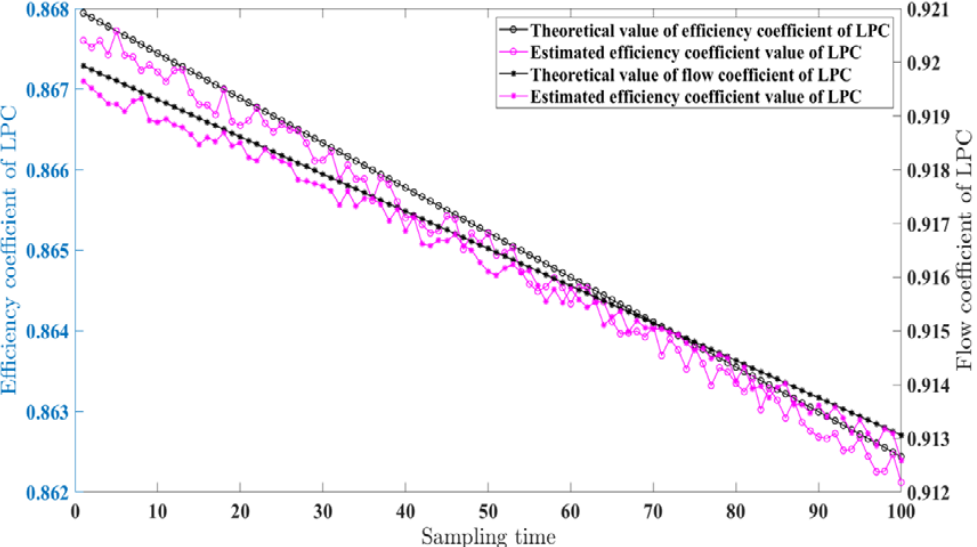
Figure 6. Estimated health parameters of low-pressure compressor by the traditional unscented Kalman filter and particle filter.